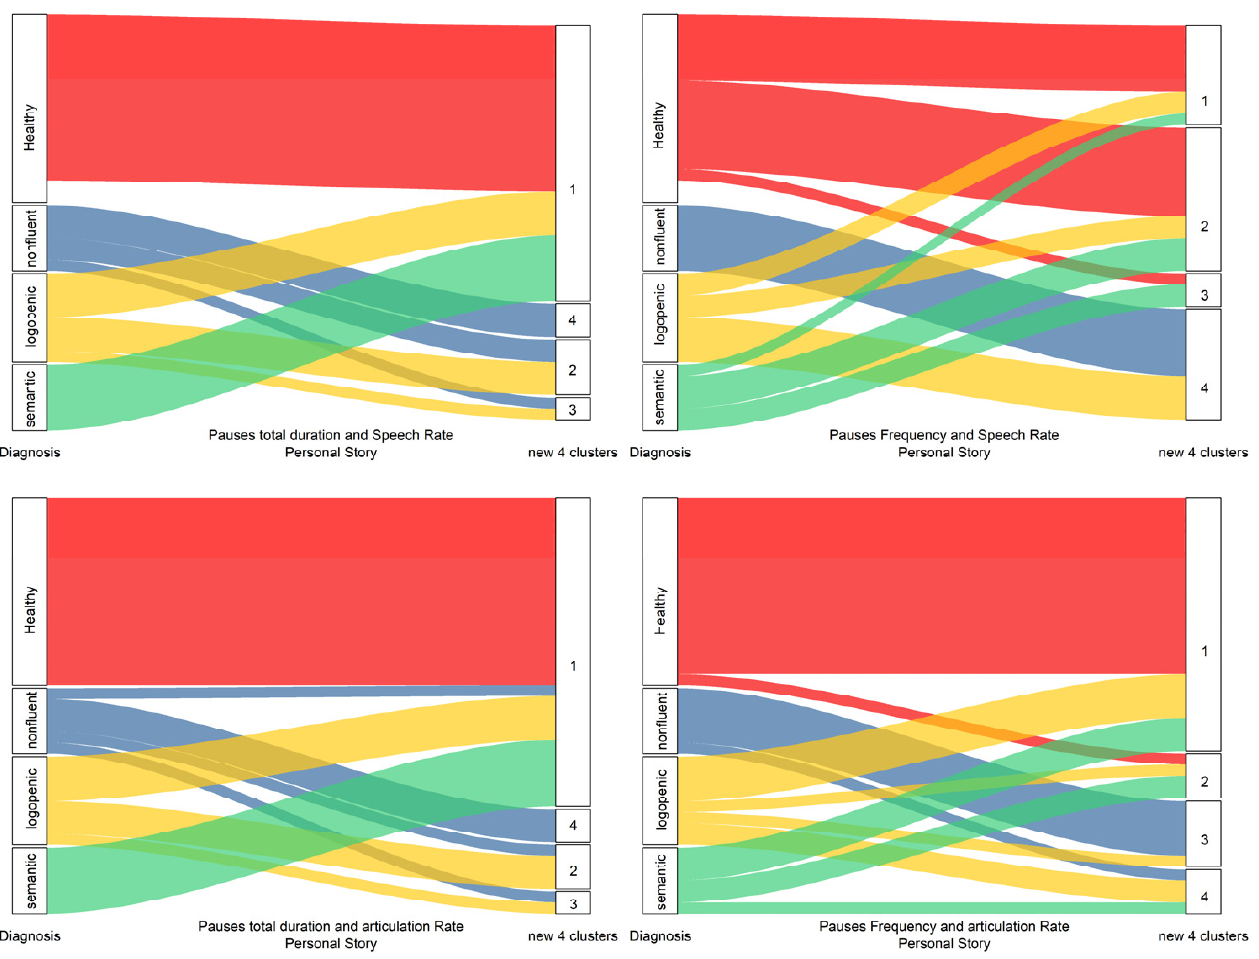
Figure 8. Re-classification of data for the personal story narration task. First node is the initial diagnosis.